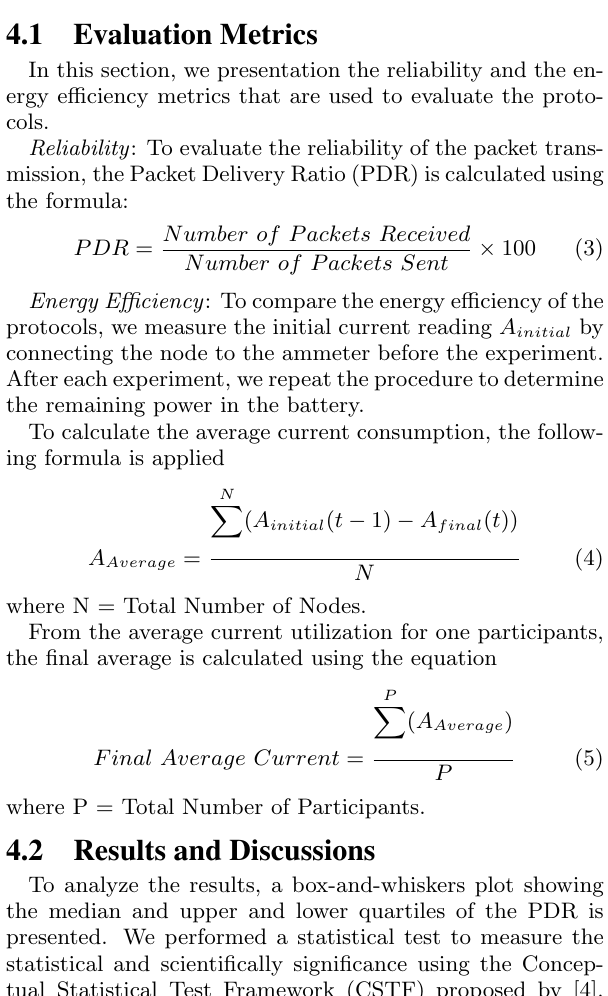
Figure 2: The A-MAC in IEEE 802.15.5 Protocol Stack